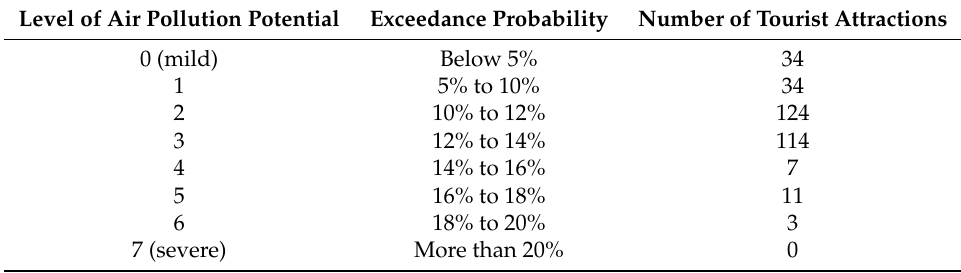
Figure 5. Distribution of PM 2.5 potential in tourist areas in Hsinchu County in spring in 2017. Table 3. Levels of air pollution potential and numbers of affected tourist attractions.